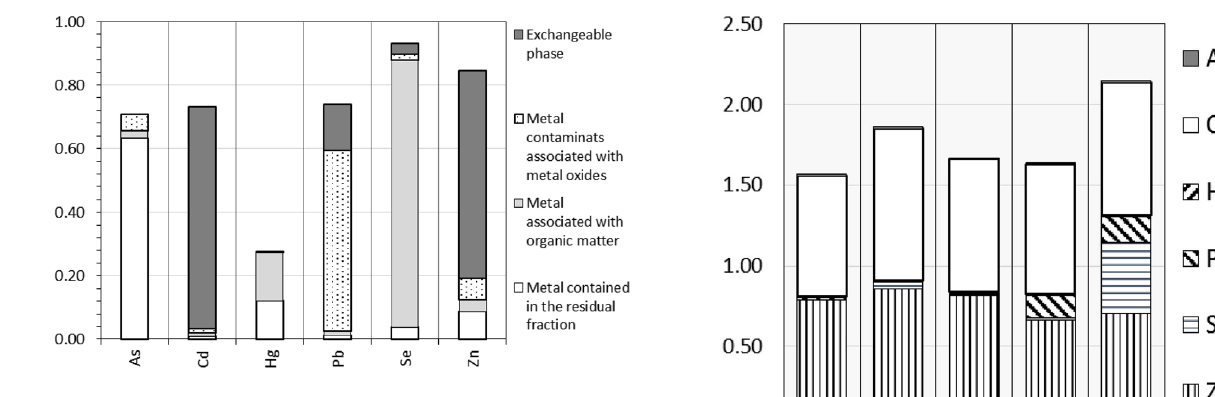
Fig. 3 Fractionation of As, Cd, Hg, Pb, Se and Zn in the contam- inated soil